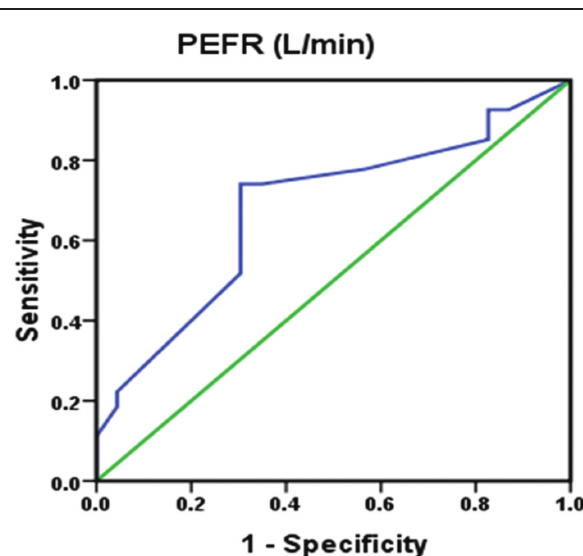
ROC curve of optimal cut-off level of PEFR ≤ 225L/min associated with treatment failure with sensitivity of 74.1 % and specificity of 69.6%.